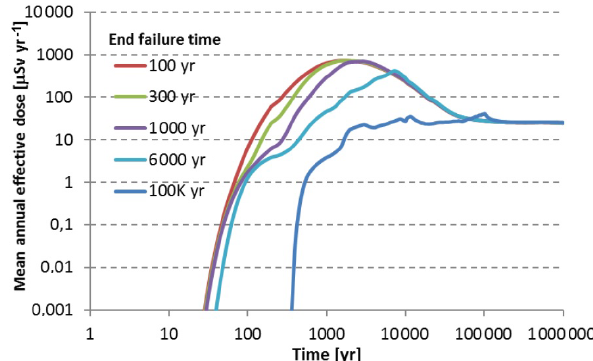
Figure 1. All 6000 canisters fail evenly distributed in different given time frames. Can failures 1–100 years, 1–300 years, 1–1000 years, 1–6000 years and 1–100000 years. Dose for canisters failure under conditions of intact buffer conditions. Parts of the rock without any intersecting fractures at all do not contribute to